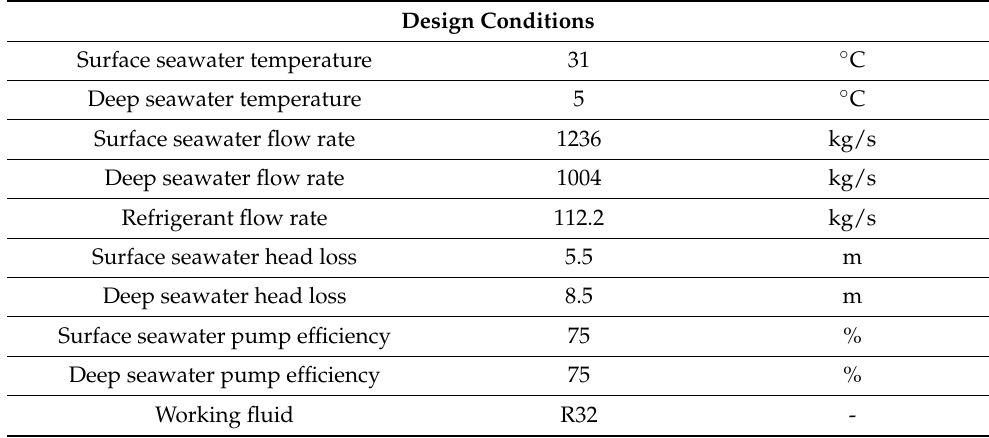
Table 2. Specifications of the 1 MW OTEC cycle.